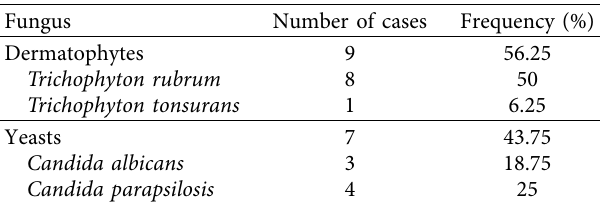
Table 3: Fungi isolated in nail culture of individuals with psoriatic